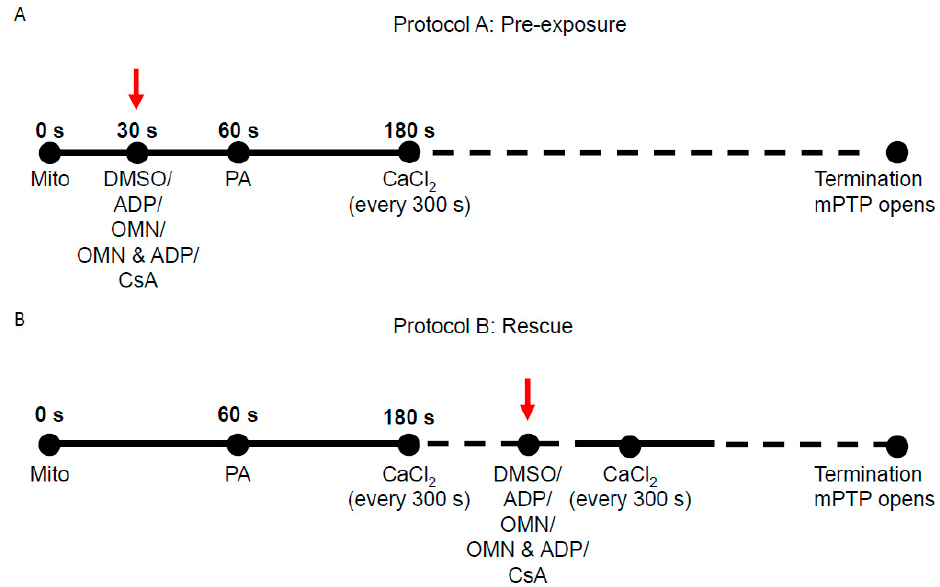
Figure 1. Schema of experimental timeline used to study the effect of Cyclosporin A (CsA) and adenine nucleotide (AdN) on mitochondrial Ca 2+ handling and bioenergetics during repeated CaCl 2 pulses. ( A ) In Protocol A, at t = 0 s, mitochondria (mito, 0.5 mg) were added to the Na + -free experimental buffer solution. The mitochondrial suspension was exposed to 0.5 µM CsA, 250 µM ADP, 10 µM oligomycin (OMN), or a combination of OMN+ADP at t = 30 s. Pyruvic acid (PA, 0.5 mM), was added at t = 60 s to energize mitochondria (state 2). At t = 180 s, 20 µM of CaCl 2 was added, followed by sequential additions of 20 µM CaCl 2 at every 300 s intervals until mPTP (mitochondrial permeability transition pore) opened or no further Ca 2+ uptake was observed. ( B ) In Protocol B, the mitochondrial suspension was exposed to similar treatments as in Protocol A, but given after the last consecutive CaCl 2 bolus preceding the imminent onset of mPTP opening.